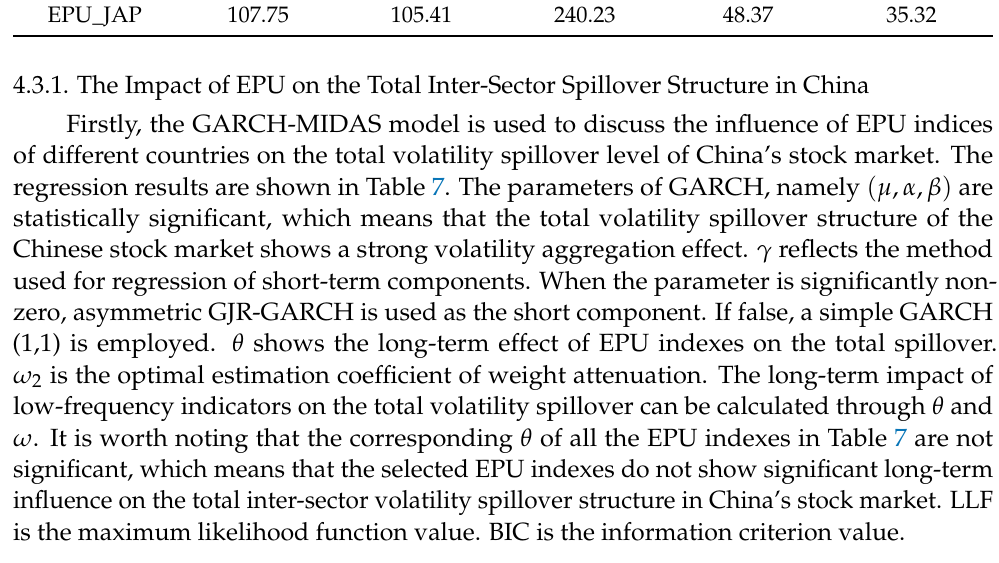
Table 7. GARCH-MIDAS results of EPU index on total inter-sector spillover level in China 5